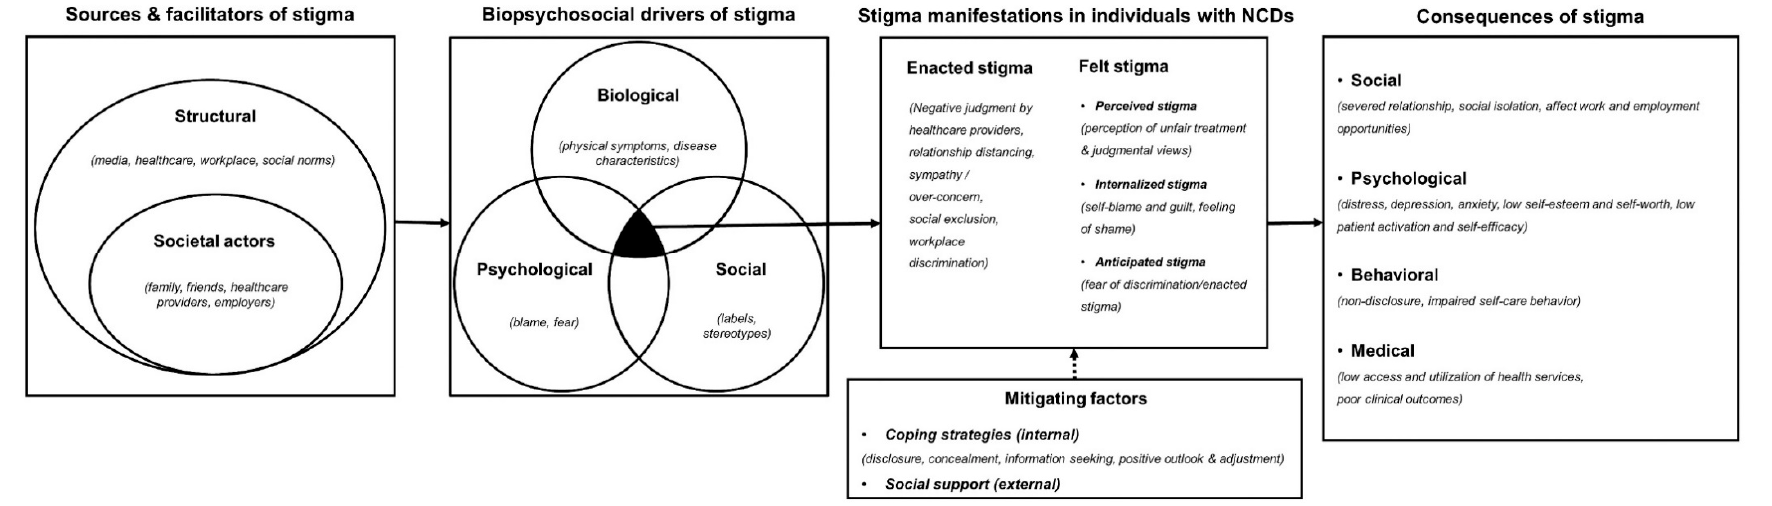
Figure 2. A revised framework for understanding non-communicable disease (NCD)-related stigma.